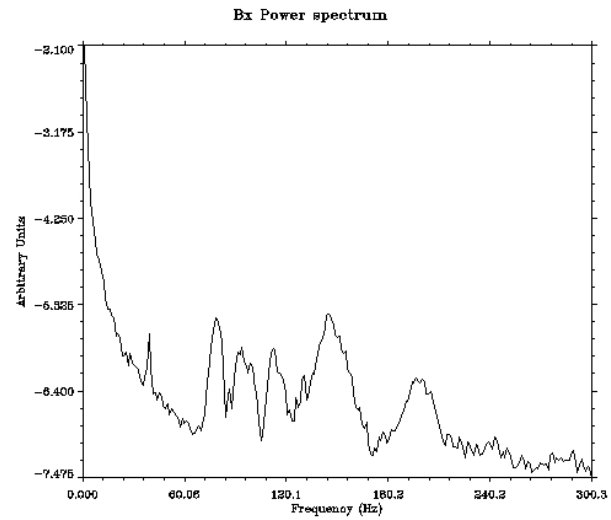
Fig. 4. Spectrum of the magnetic component calculated for the first forty seconds of Fig. 3.